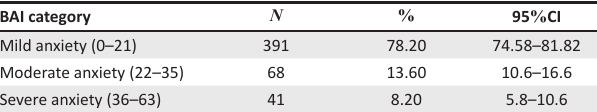
TABLE 2: Percentage of sample in each Beck anxiety inventory category. TABLE 1: Sample demographic characteristics.